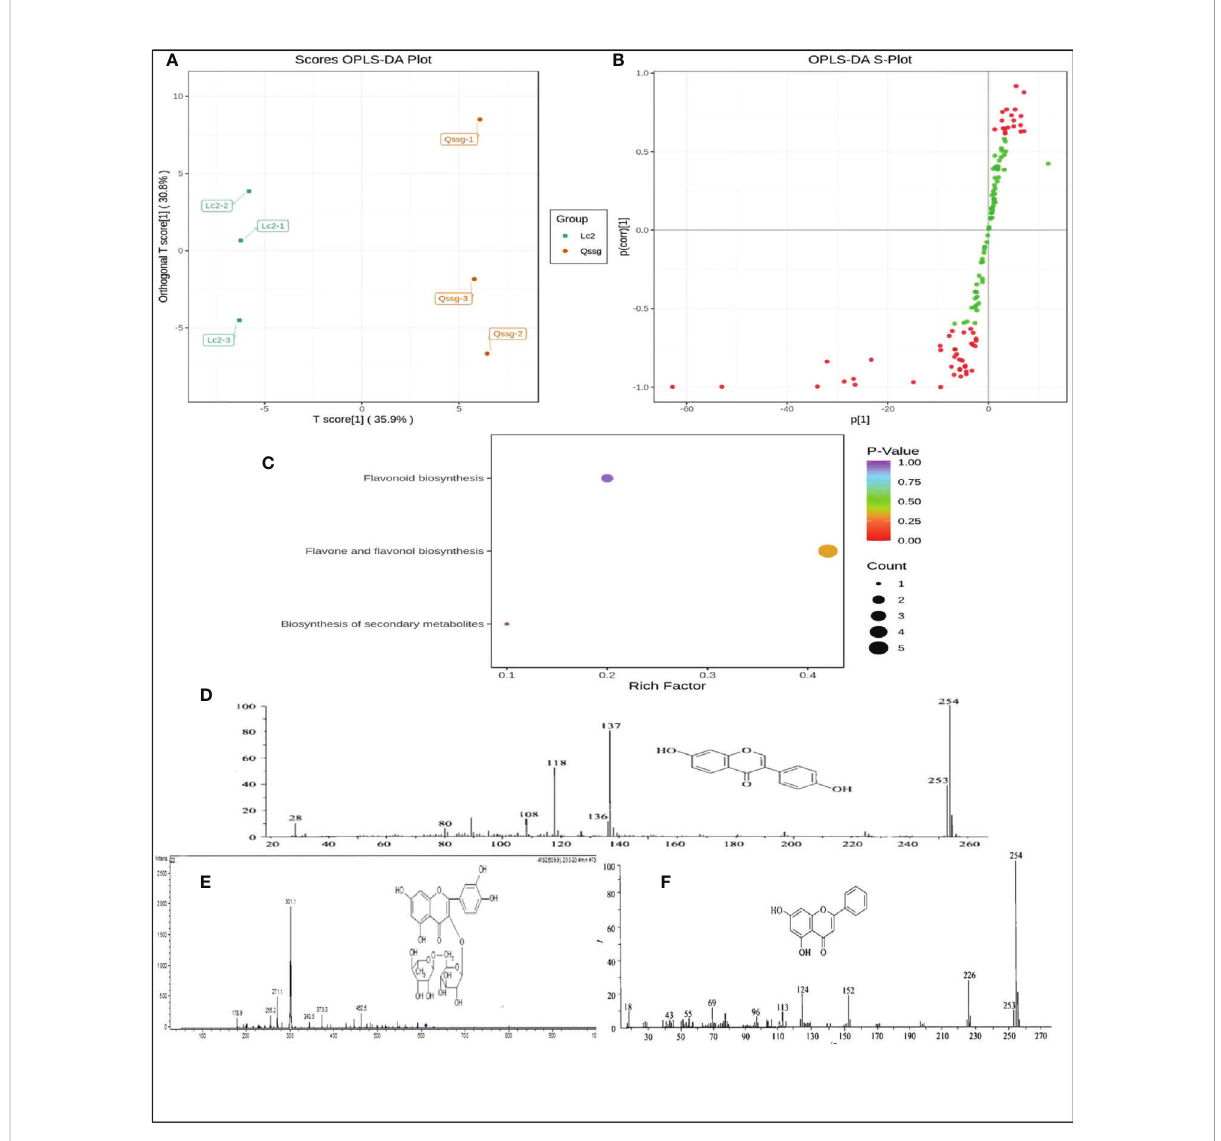
FIGURE 3 Difference of fl avonoids in Qssg ang Lc Actinidia arguta Sieb.Zucc ., enrichment analysis results of KEGG pathway and structure diagram of Rutin, Chrysin and Daidzein. (A) Opls-da score map of metabolites in Qssg and Lc fruits, and each point represents an independent biological repeat. (B) OPLS-DA S-plot of metabolites in Qssg and Lc fruits(p<0.05). (C) KEGG classi fi cation map of differential metabolites in Qssg and Lc fruits. (D) Rutin ionization and mass spectrum.e ionization and mass spectrum of populin. (E) Chrysin ionization and mass spectrum. (F) Daidzein ionization and mass